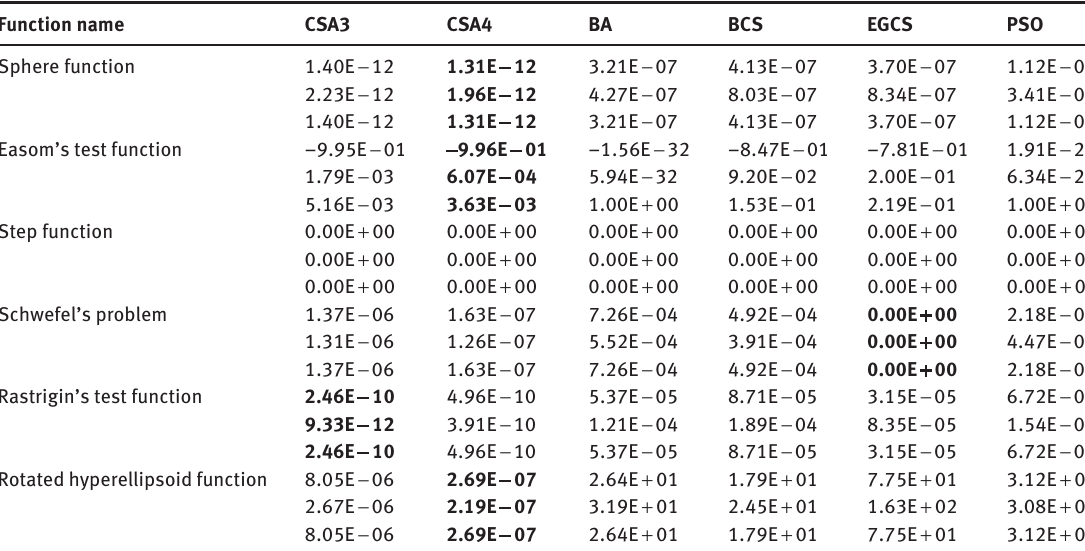
Table 11: Comparison Results of CSA3 and CSA4 to Four Other Optimization Algorithms.